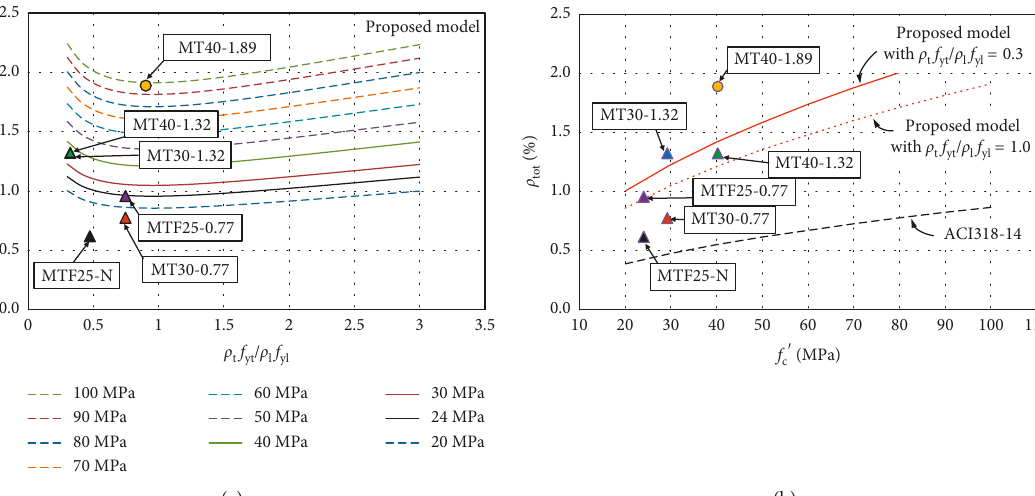
f f yt / ρ l yl ; (b) total reinforcement t